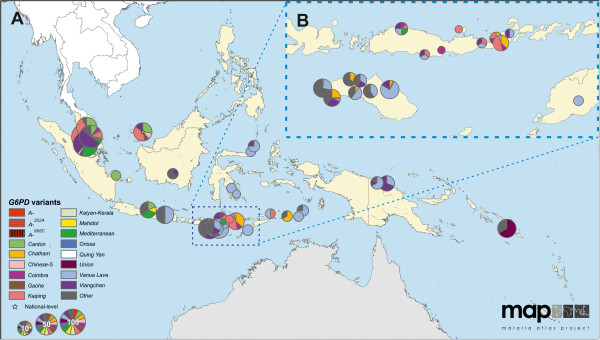
G6PDd variant proportion map: Asia-Pacific (map series 1). Panel A show the full map, which includes 36 surveys with a mean sample size of 18 (range: 1-128). One survey was mapped at the national level. The East Nusa Tenggara province islands identified by the dotted box are shown at higher resolution in Panel B. (See Figure 
2 for full legend).